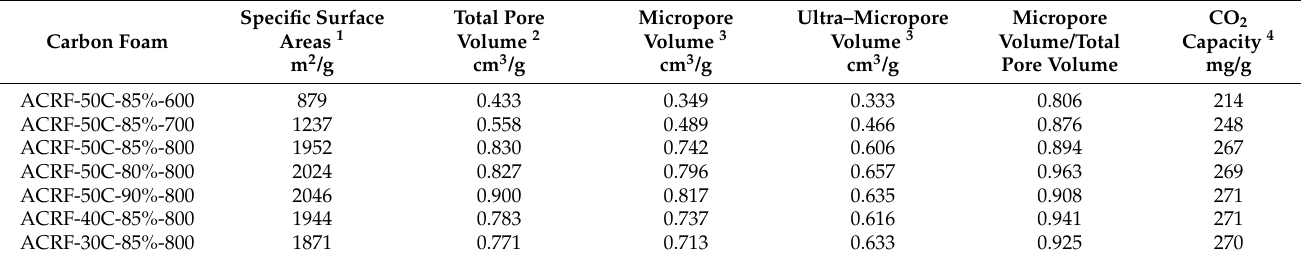
Figure 6. CO 2 capacities of ACRFs at 273 K.